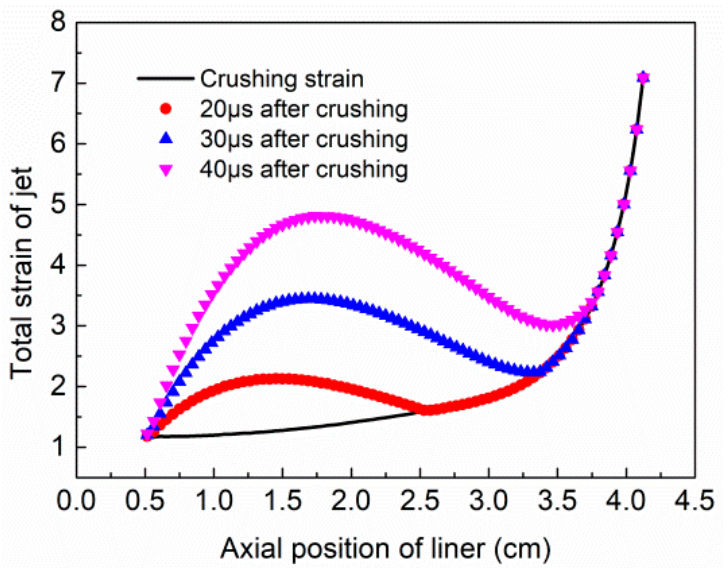
Figure 7. Total strain of the jet. Figure 8a,b show the theoretically calculated and numerically simulated distribution patterns of the strains of the jets formed from the OFHC-Cu and Mo liners 40 µ s after detonation, respectively. The analysis revealed no significant difference in the distribution of the strain between the jets formed from the liners made of the two materials in the presence of the same warhead structure. Compared with the theoretical model, numerical simulations were effective in predicting the distribution of the strain in the direction transverse to the stretching direction of each jet. At 40 µ s, the average strains at the heads of the OFHC-Cu and Mo jets were 5.62 and 5.37, respectively. As shown in Figure 8a, the maximum strains at the heads of the two jets predicted by the theoretical model were 4.86 and 4.58, respectively. The primary reason that the theoretical predictions are lower than the numerical simulation results is that the theoretical model only considers the plastic strain accumulation during the collapse and 1D tensile motion of the jet, while neglecting the stratified flow inside the jet